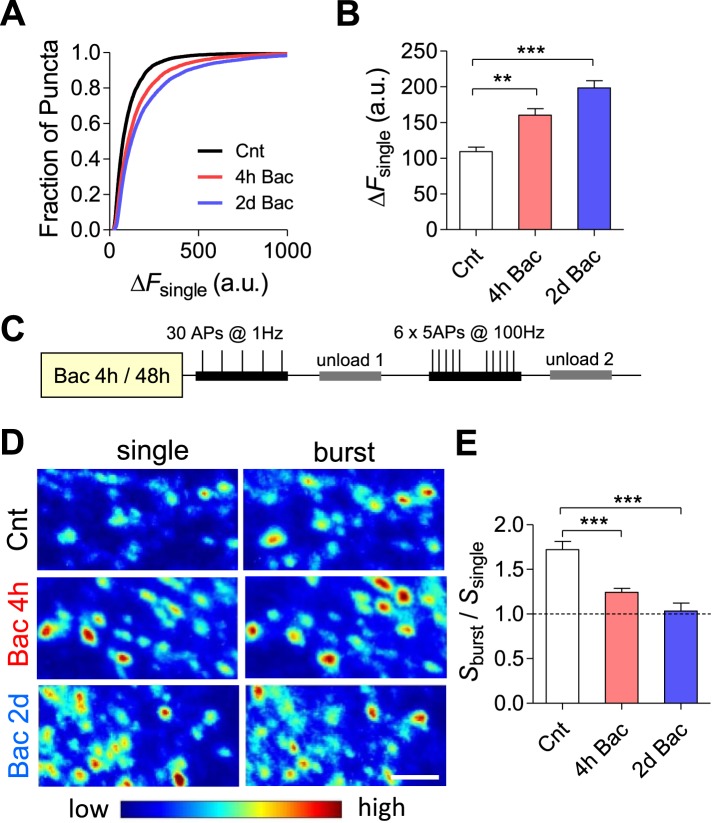
Short-term synaptic plasticity is not preserved in networks with similar firing properties.(A) Cumulative histogram of fluorescence intensity of FM stained puncta following 30 stimuli given at 1 Hz. (ΔFsingle control, n = 15; 6099 puncta; 4 hr, n = 15, 6269 puncta; 2 days, n = 13; 5551 puncta.) (B) Summary of mean ΔFsingle from (A). Mean ΔFsingle is increased already after 4 hr of incubation with baclofen and remains high after 2 days of baclofen incubation. ***p < 0.001; one-way ANOVA with Tukey's multiple comparison test. (C) Experimental protocol used for STP experiments. (D) Representative images of FM1-43 staining from STP experiments. Note the increase in fluorescence intensity after 1 Hz stimulation following baclofen incubation. Scale bar: 5 µm. (E) The mean burst-to-single ratio of S is significantly decreased following baclofen incubation (control, n = 15; 4 hr, n = 15; 2 days, n = 13; p < 0.0001). ***p < 0.001; one-way ANOVA with Tukey's multiple comparison test. Error bars represent SEM.